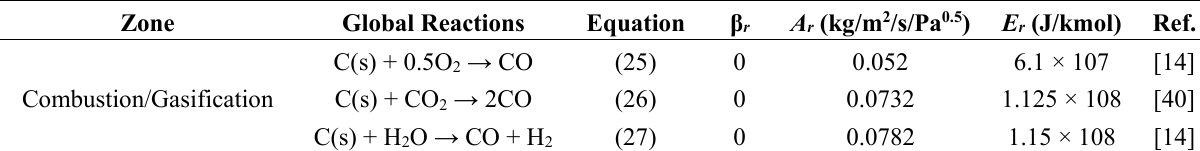
Table 3. Kinetic parameters for char gasification (heterogeneous